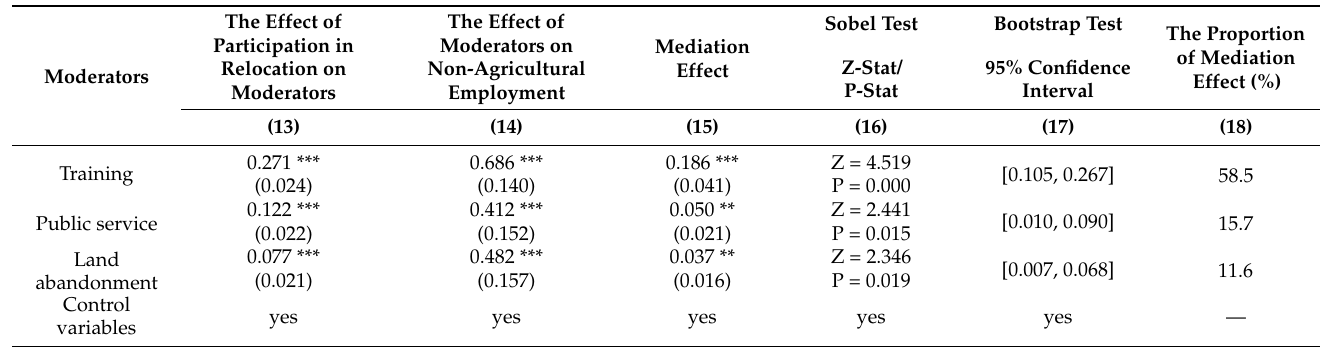
Table 5. Estimated results of the mediation effect in the effect of participation in relocation on non-agricultural employment